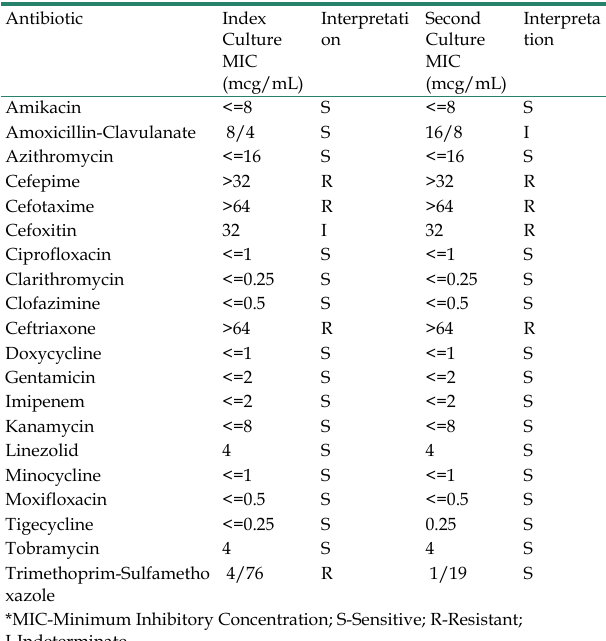
Table 1: Culture sensitivities from Mycobacterium senegalense isolates